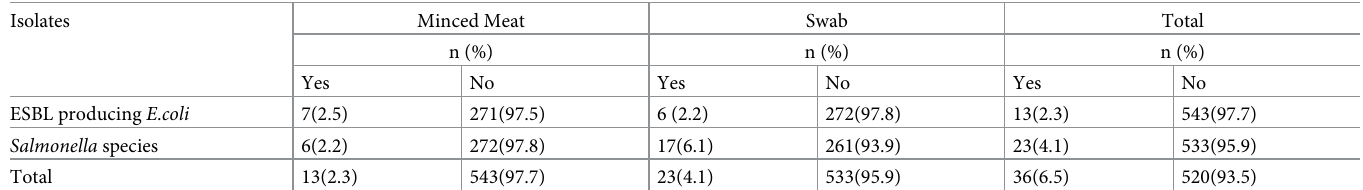
Table 2. Prevalence of Salmonella species and ESBL producing E . coli from raw meat and swab samples collected from butcher shops at Hawassa city Sidama regional state, Ethiopia, 2020 (n = 556). Isolates